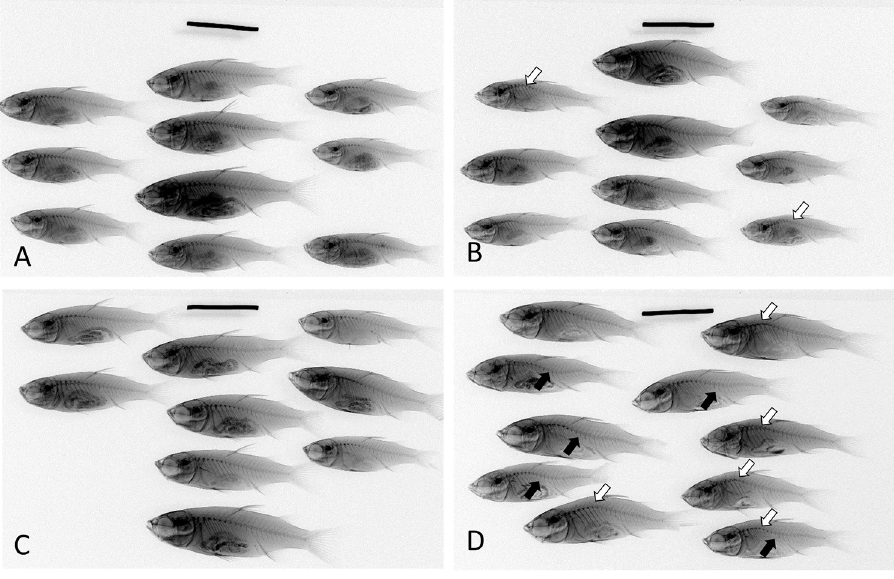
Fig 2. Lateral X-ray views of largescale mullet in Experiment 1. Fish were maintained for (A) 2 weeks at 26˚C, (B) 2 weeks at 36˚C, (C) 4 weeks at 26˚C, or (D) 4 weeks at 36˚C prior to X-ray. Open arrows indicate kyphosis, and solid arrows indicate lordosis. Scale bar, 10